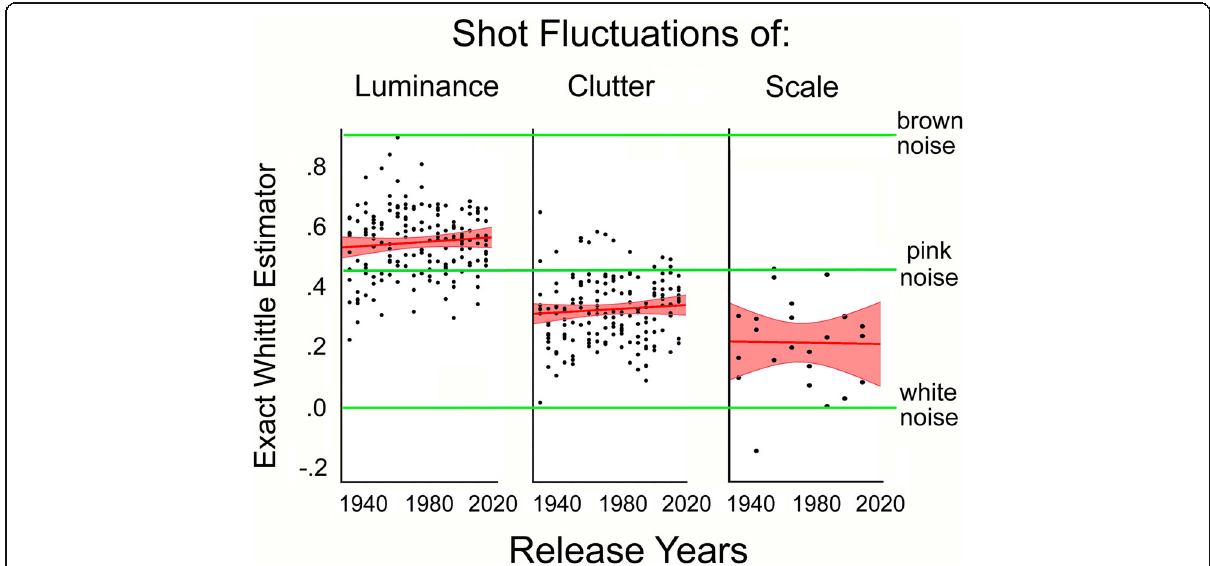
Fig. 8 Results of Study 6 for Whittle estimates of three dimensions in the shots of movies. Left: The unchanging Whittle values for shot-luminance vectors across release year for 180 movies. Middle: The same measure for shot-clutter vectors for 180 movies. Right: Shot-scale vectors in 24 movies. The upper horizontal green line represents the approximate value of 1/ f 2 (brown noise) as determined in Study 3, the middle line represents the approximate value of 1/ f 1 (pink noise), and the lower line the value of 1/ f 0 (white